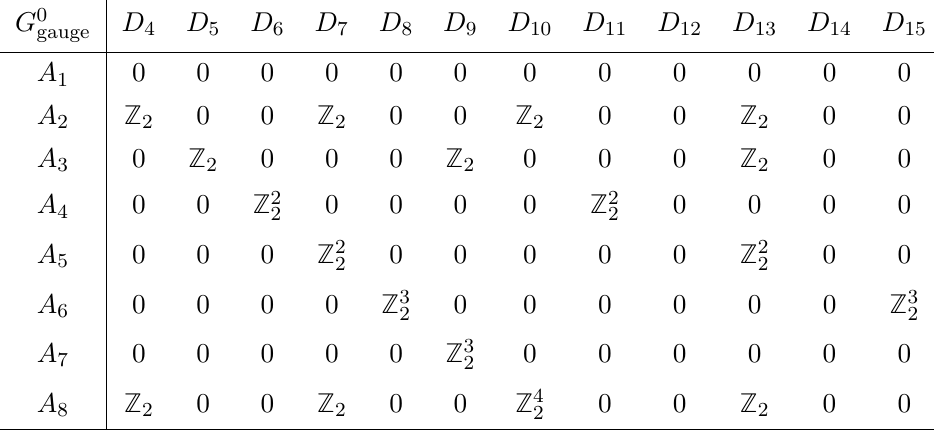
Table 5 . Discrete gauge groups of ( A k , D n ) theories modded by the center of SO(2 n )